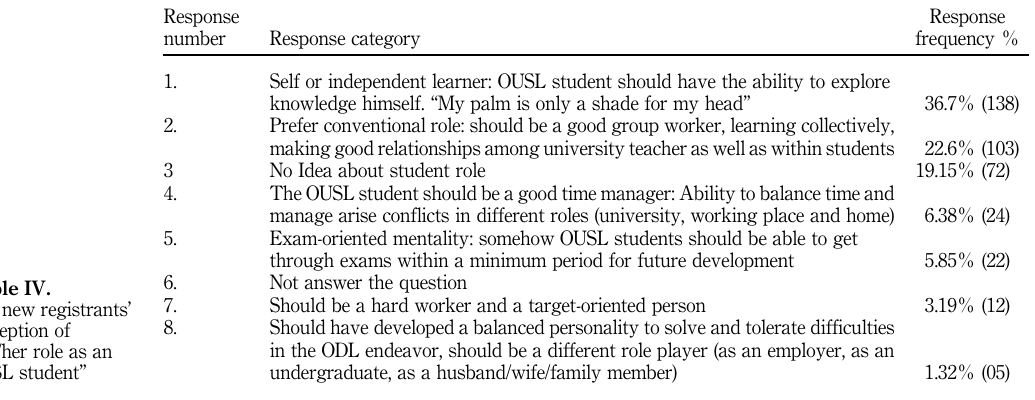
teacher at OUSL: as perceived by BSc new